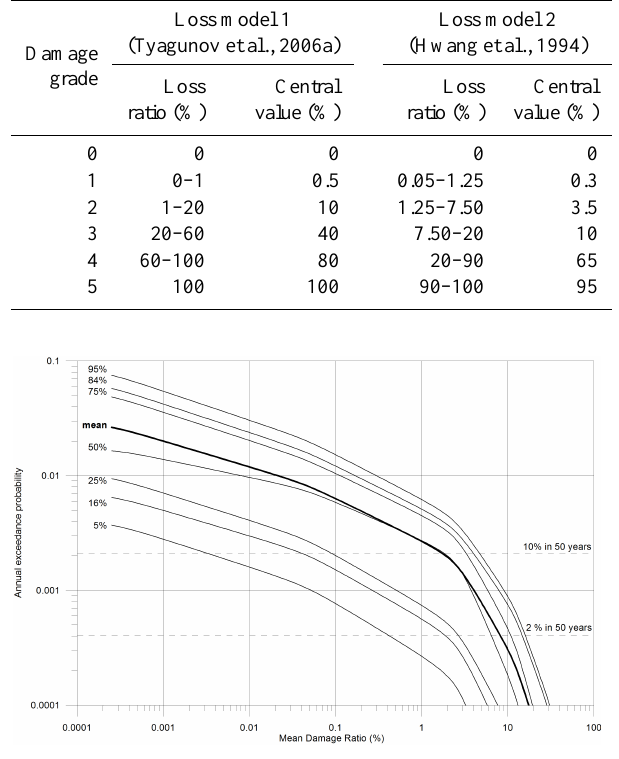
Figure 9. Calculated mean and quantile risk curves (in terms of MDR) for the whole range of the logic tree branches (Fig. 1).